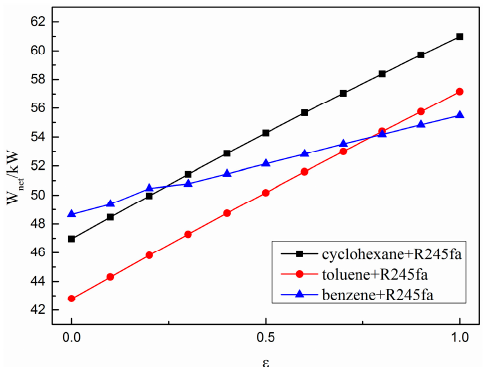
Figure 6. The effect of regenerator efficiency on the net output power of the cycle. Figure 6 . The effect of regenerator efficiency on the net output power of the cycle.